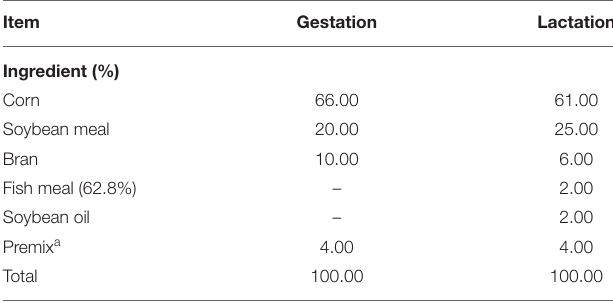
TABLE 1A | Composition and nutritional value of the diet (as-fed basis).